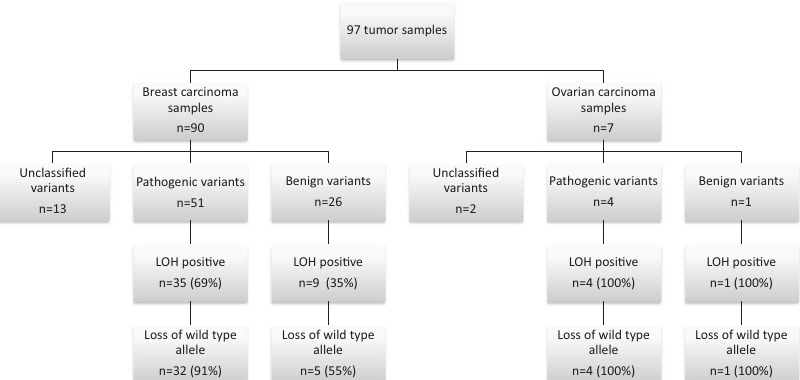
Fig. 1 Summary of BRCA locus-speci fi c LOH status of breast and ovarian tumors from individuals with germline BRCA1 variants. In this fi gure are presented all the results obtained according to the type of tumor and the class of variant identi fi ed.